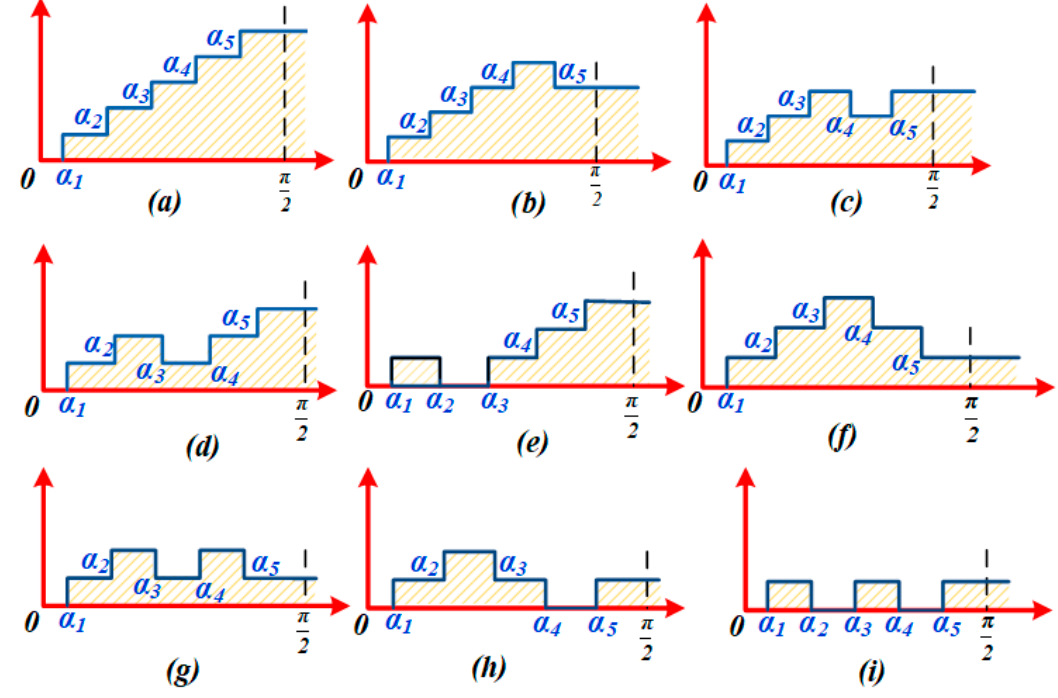
Figure 3. Differentpattern synthesis switching transitions from the 11-level cascaded H-bridge inverter. ( a )